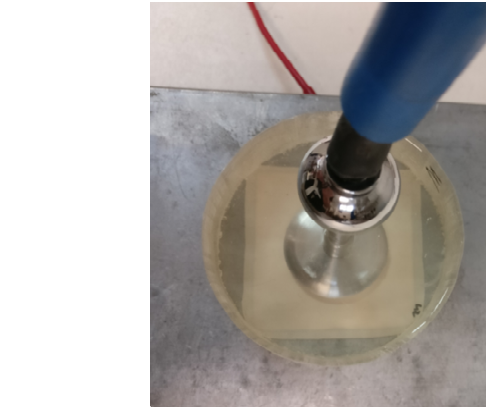
Figure 6. Experimental setup with a dielectric layer of epoxy resin and the electrode surrounded by epoxy resin too.